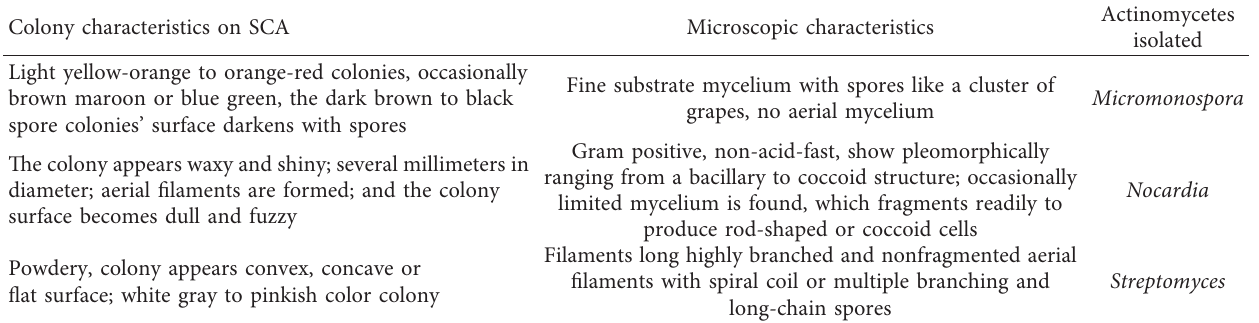
Table 1: Identification of actinomycetal isolates based on morphological and cultural characteristics. Colony characteristics on SCA